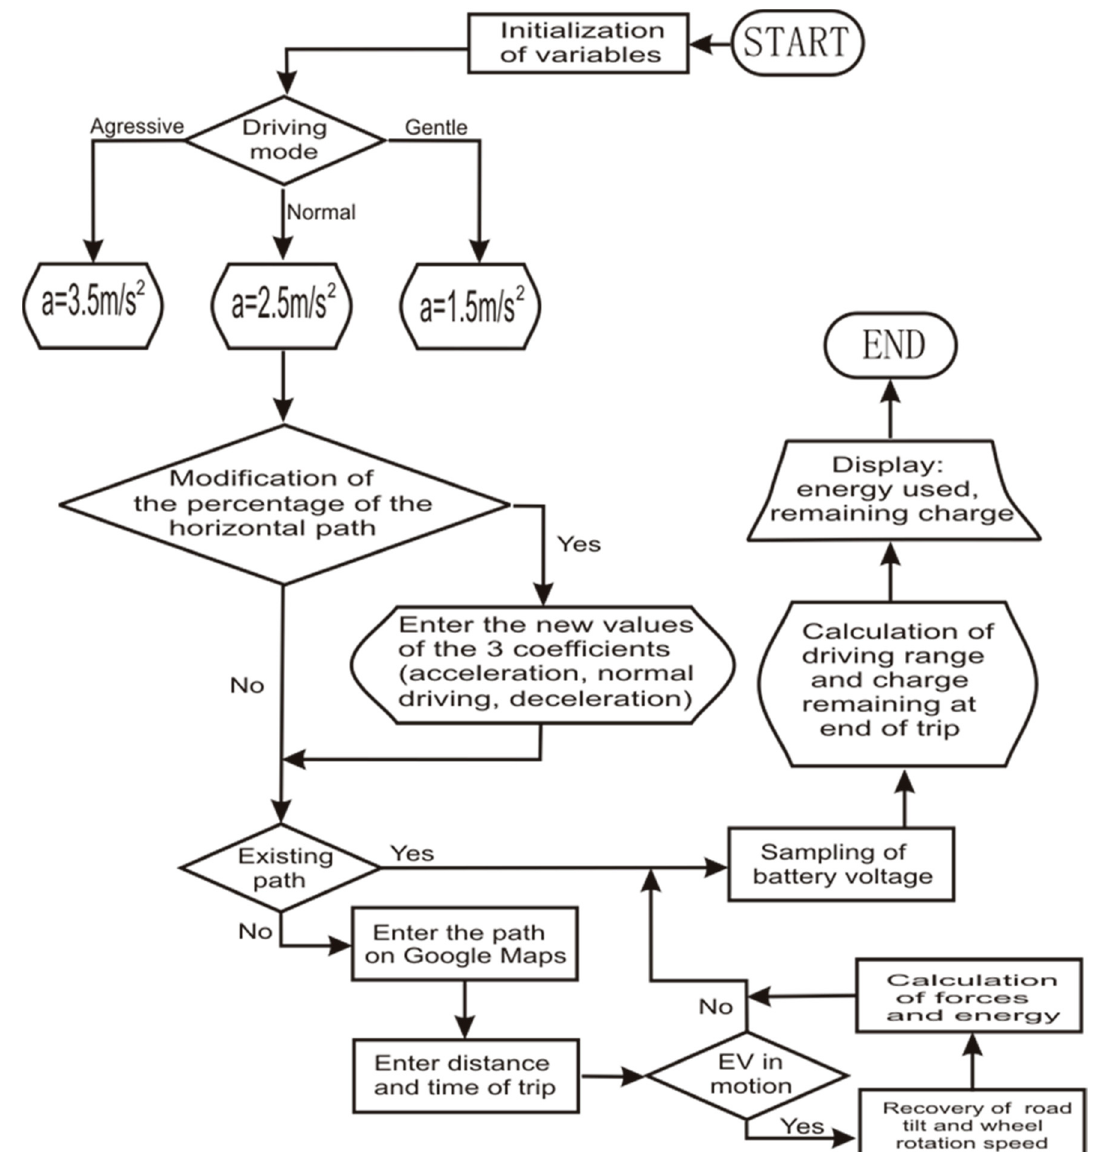
Figure 6. Software program flowchart.